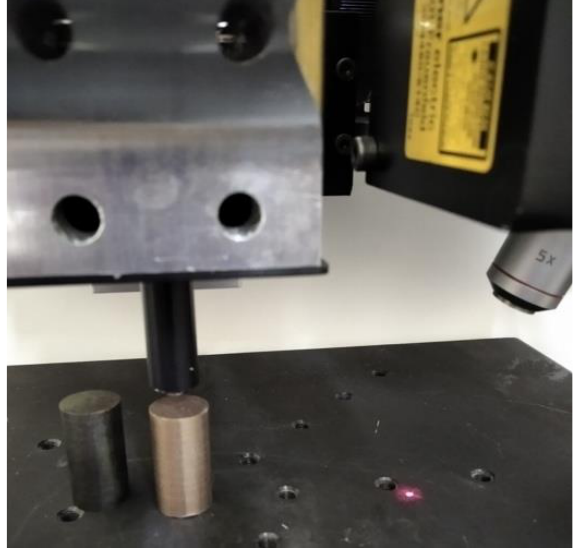
Figure 7. Specimen’s fixation for the nanoindentation test.